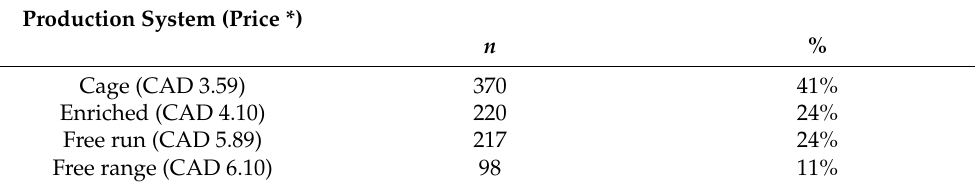
Table 4. Distribution of choices for a dozen eggs.